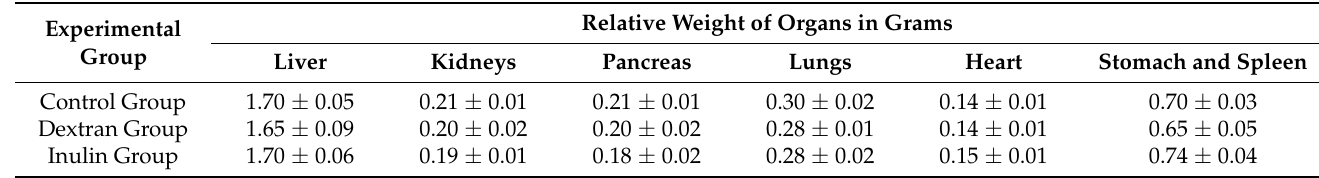
Table 2. Comparison of organ weights of mice from different diet